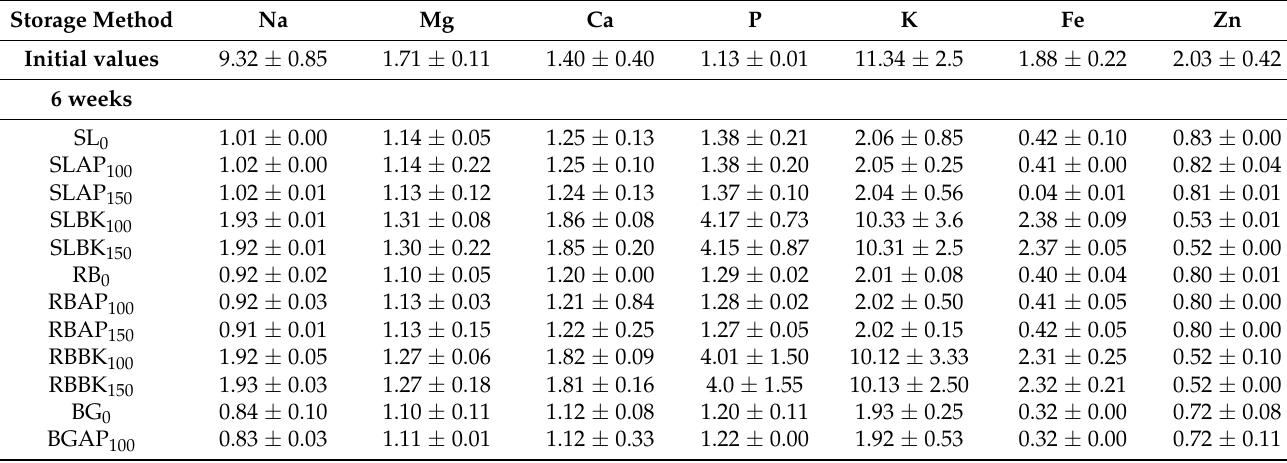
Table 5. Variation in the mineral compositions of the stored breadfruits using different